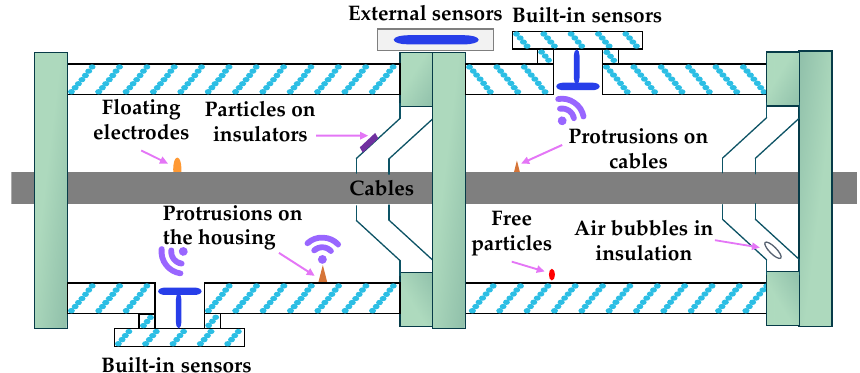
Figure 12. Partial discharge UHF detection method principle.